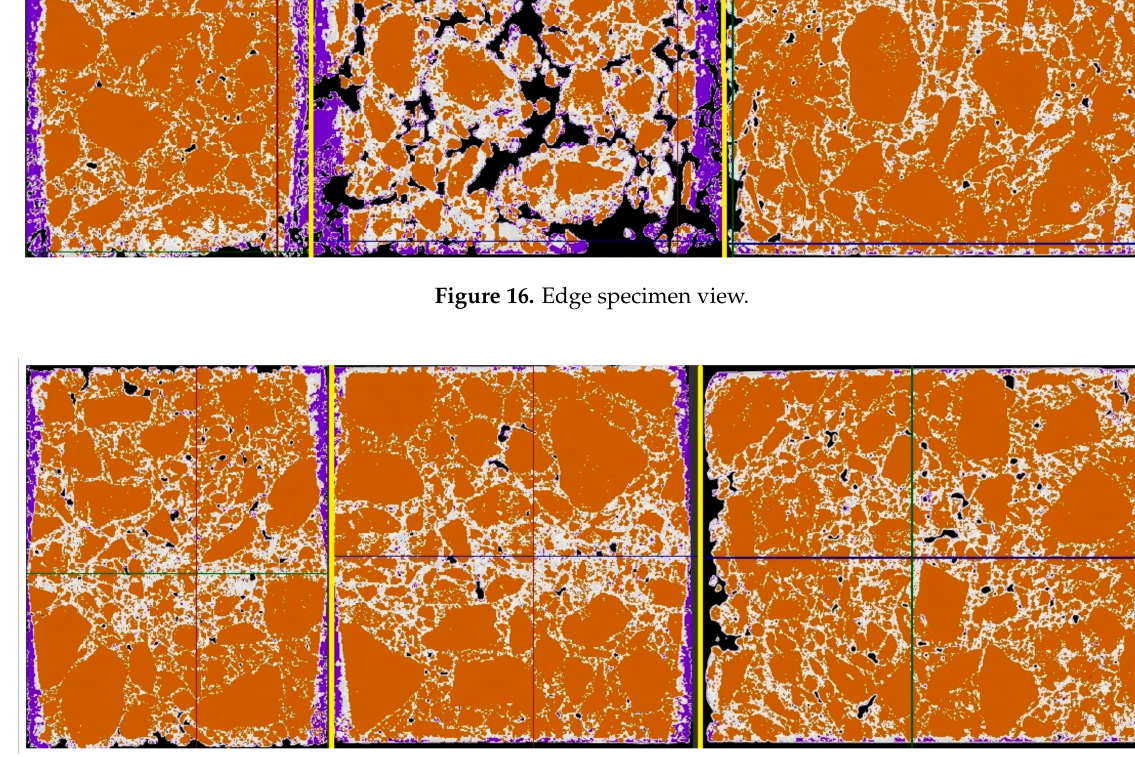
Figure 17. Middle specimen